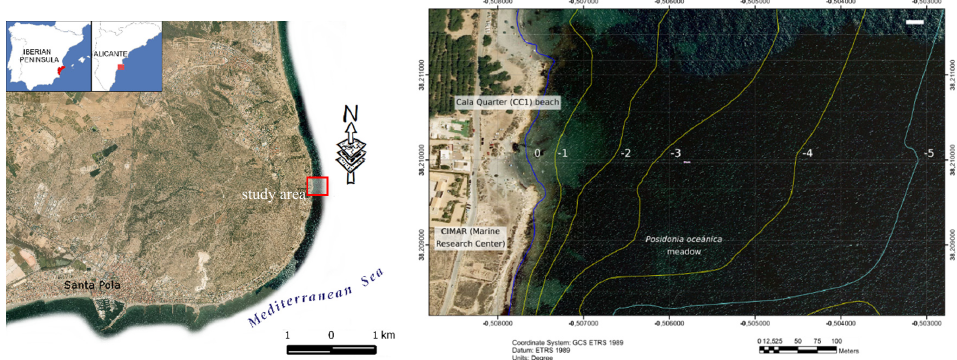
Figure 1. Geographical location of the studied beach in the context of the western Mediterranean. The figure on the left was prepared by Francisco Asensio-Montesinos.